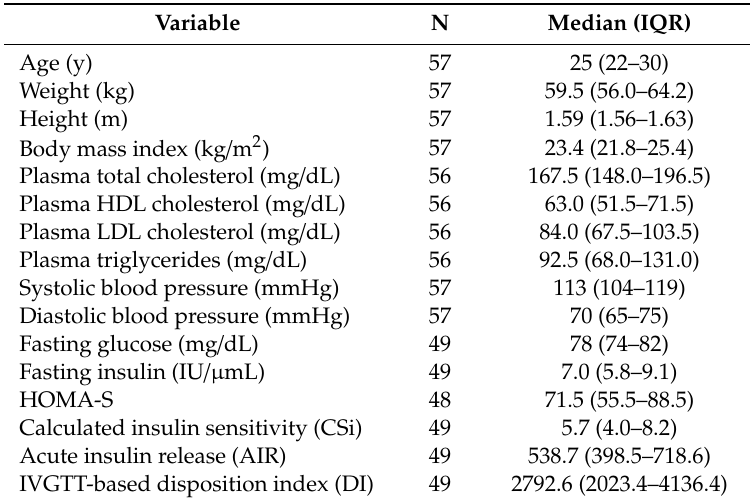
Table 1. Anthropometric and biochemical measurements, and insulin sensitivity indexes of n = 57 participants of this